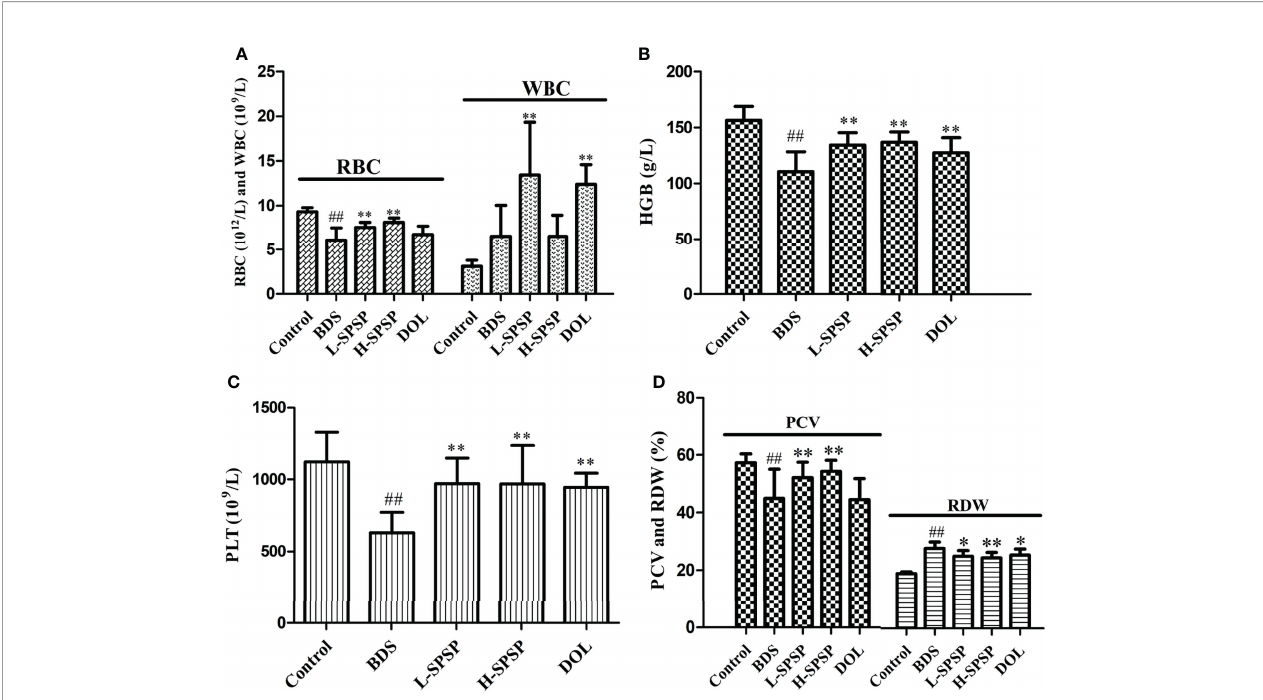
FIGURE 3 | Bloodparametersof the BDS miceafter treatment with different doses of SPSP. (A) RBC andWBC numbers. (B) The content of HGB. (C) The number of PLT. (D) The ratio of PCV andRDW.Each value isrepresentedas the mean ± SD(n = 8); ## p < 0.01 versus Control group.* p < 0.05, ** p < 0.01 versus BDS.